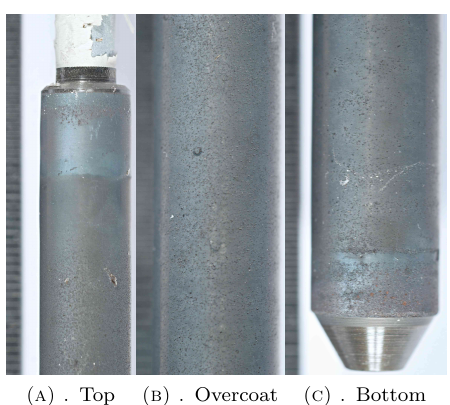
(a) . Top (b) . Overcoat (c) . Bottom Figure 14. Visual inspection of FeCrAl+Mo pressure tubes after Run 1 and Run 2 - tension.